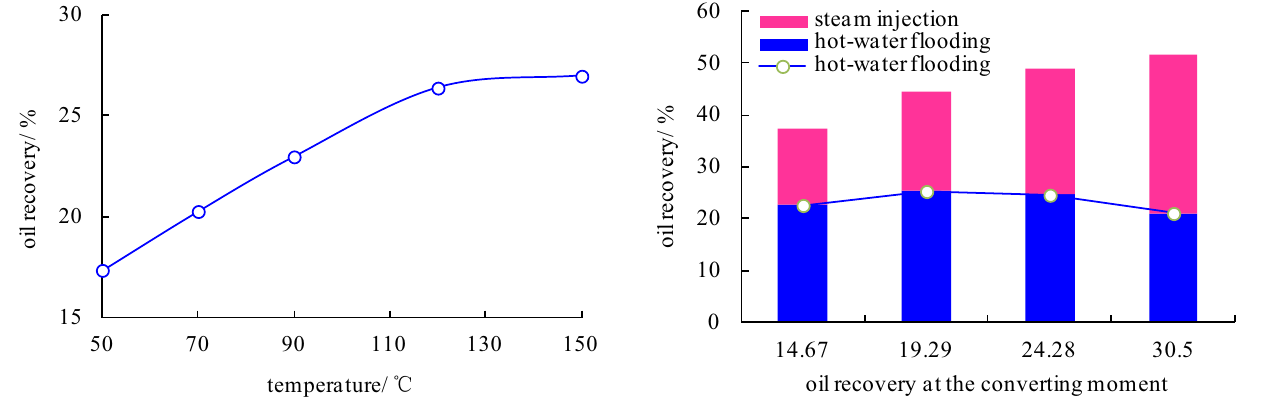
Fig. 2 Oil recovery at different temperatures